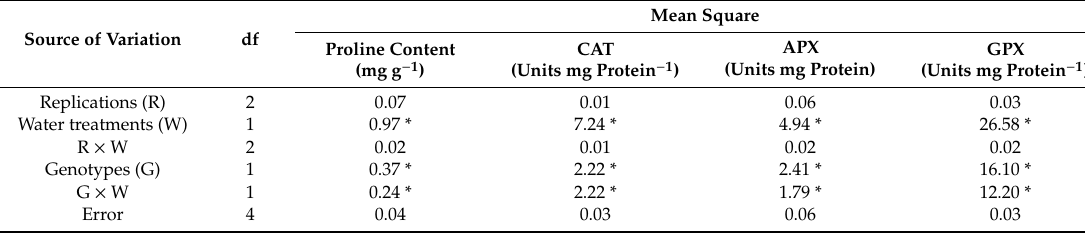
Table 5. Analysis of variance for biochemical traits.